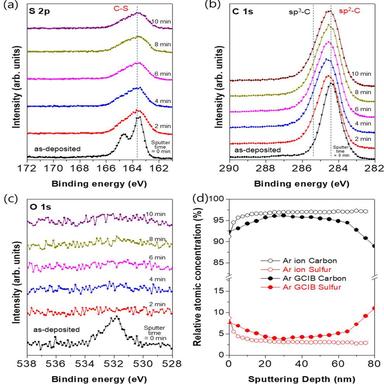
(a) S 2p, (b) C 1s, and (c) O 1s XPS depth profiles of P3HT:PC71BM/PEDOT:PSS/SiO2 structure obtained in conjunction with Ar ion sputtering. Sputtering time intervals = 2 min. (d) Comparison of atomic concentration depth profiles obtained using Ar ion and Ar gas cluster ion beam sputtering.